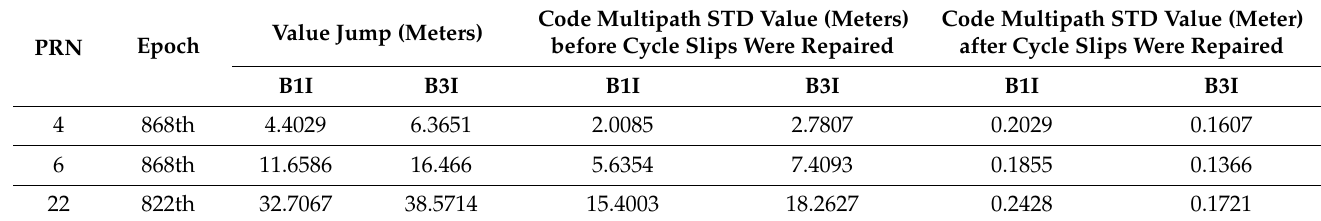
Figure 7. Combined multipath values of the B1 and B3 frequencies after the cycle slips were repaired. Table 1. Observation results of combined multipath values of the B1 and B3 frequencies.